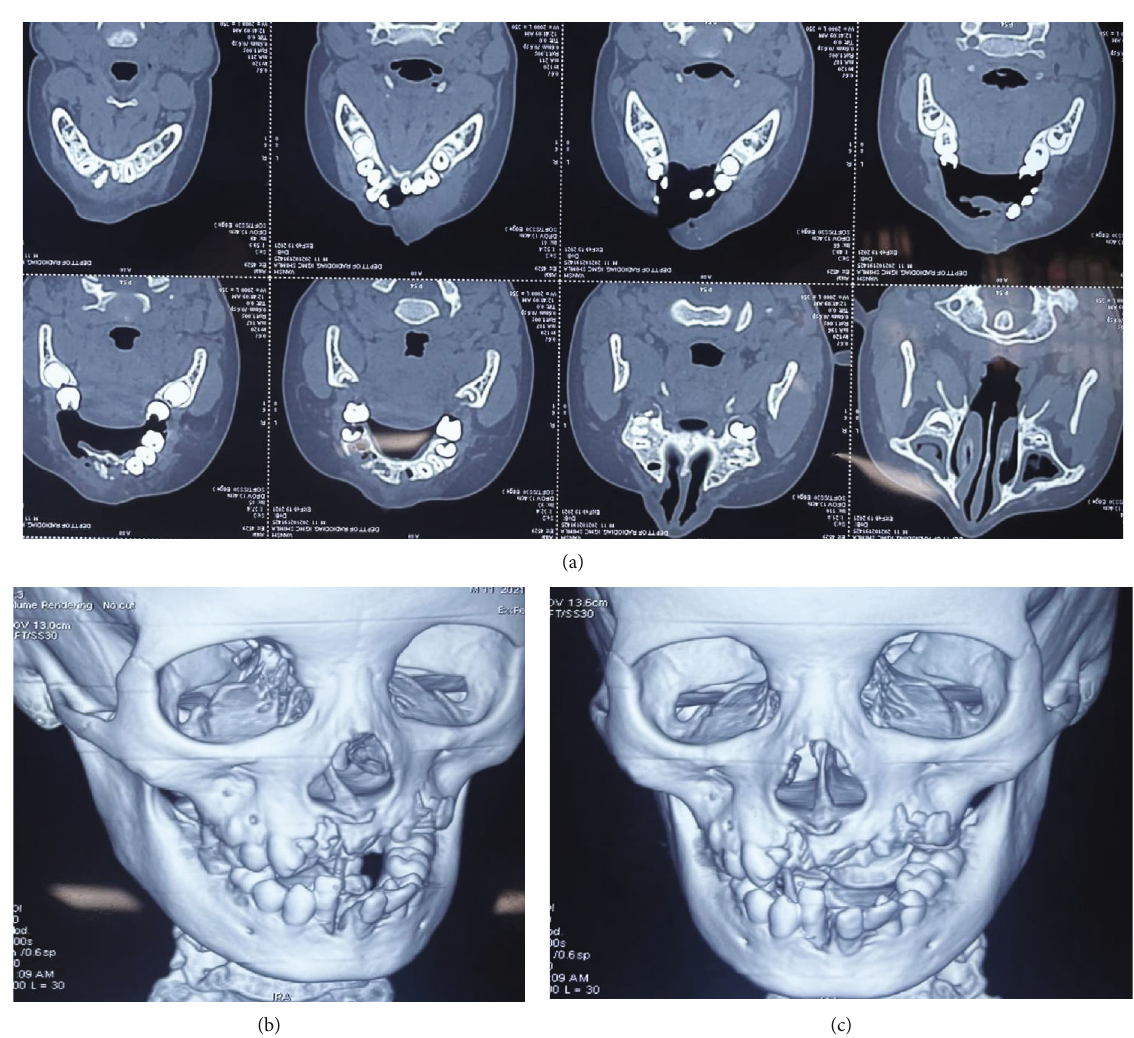
Figure 3: (a – c) Computed tomography (CT) scan showing multiple avulsions along with alveolar bone